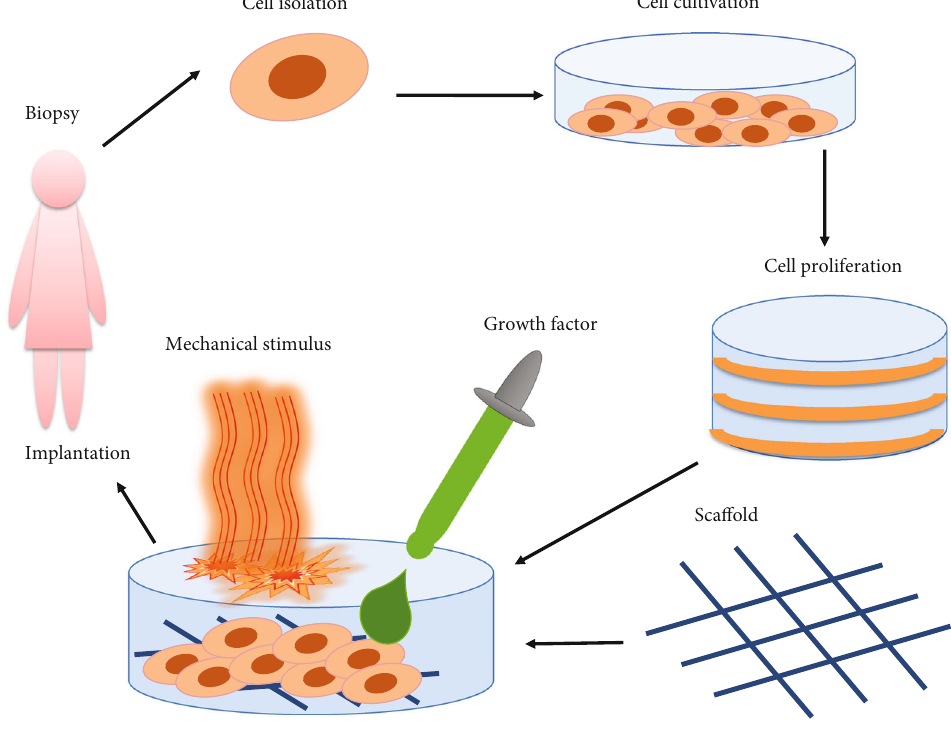
Figure 2: Regenerative medicine. The isolation of stem cells from the host through biopsy, which are encouraged to proliferate and di ff erentiate using various growth factors and physical mechanisms. After di ff erentiation, cells are transplanted back into the